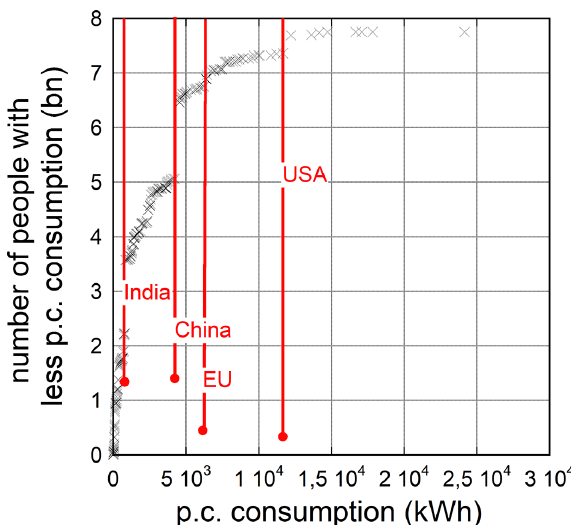
Fig. 13. – Plotted is the number of people with less per capita (p.c.) electricity consumption than the respective number of it at the abscissa. The individual data of India, China, and the USA are given as red dots. The vertical lines mark the gaps in the ordinate when the population of the respective country is added. For the European Union, there is no gap because in this case the individual countries are plotted.